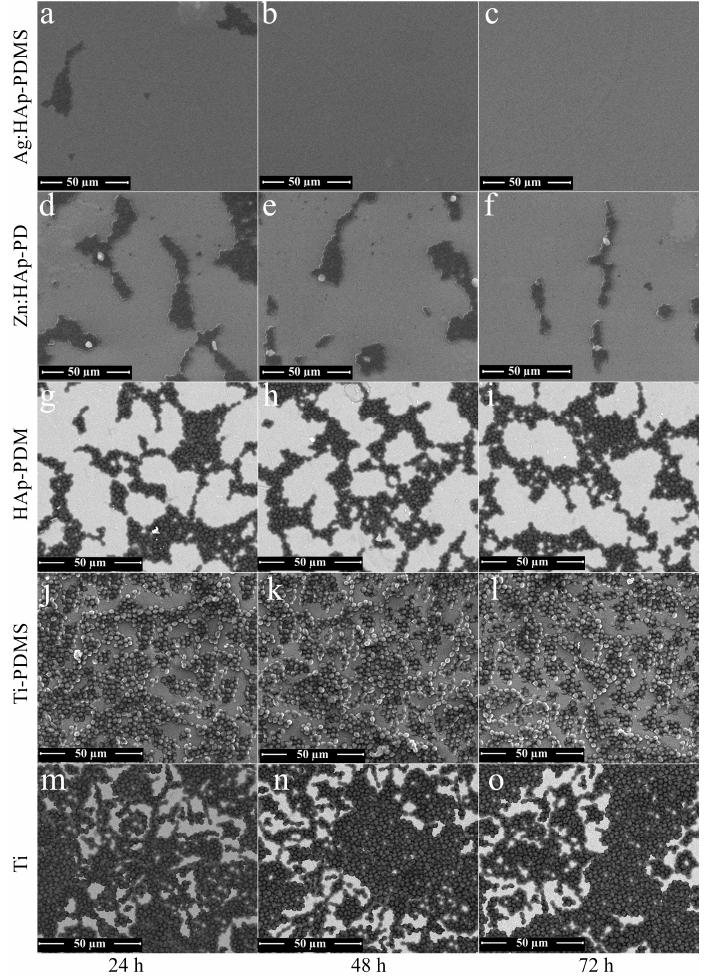
Figure 11. SEM images with a lower magnification (5000×) of C. albicans biofilm stained with propidium iodide developed on different substrates at various time intervals ( a ) cell organization in C. albicans biofilm on the surface of Ag:HAp-PDMS composite layers after 24 h; ( b ) cell organization in C. albicans biofilm on the surface of Ag:HAp-PDMS composite layers after 48 h; ( c ) cell organization in C. albicans biofilm on the surface of Ag:HAp-PDMS composite layers after 72 h; ( d ) cell organization in C. albicans biofilm on the surface of Zn:HAp-PDMS composite layers after 24 h; ( e ) cell organization in C. albicans biofilm on the surface of Zn:HAp-PDMS composite layers after 48 h; ( f ) cell organization in C. albicans biofilm on the surface of Zn:HAp-PDMS composite layers after 72 h; ( g ) cell organization in C. albicans biofilm on the surface of HAp-PDMS composite layers after 24 h; ( h ) cell organization in C. albicans biofilm on the surface of HAp-PDMS composite layers after 48 h; ( i ) cell organization in C. albicans biofilm on the surface of HAp-PDMS composite layers after 72 h; ( j ) cell organization in C. albicans biofilm on the surface of Ti-PDMS composite layers after 24 h; ( k ) cell organization in C. albicans biofilm on the surface of Ti-PDMS composite layers after 48 h; ( l ) cell organization in C. albicans biofilm on the surface of Ti-PDMS composite layers after 72 h; ( m ) cell organization in C. albicans biofilm on the surface of Ti-PDMS composite layers after 24 h; ( n ) cell organization in C. albicans biofilm on the surface of Ti-PDMS composite layers after 48 h; ( o ) cell organization in C. albicans biofilm on the surface of Ti-PDMS composite layers after 72 h.